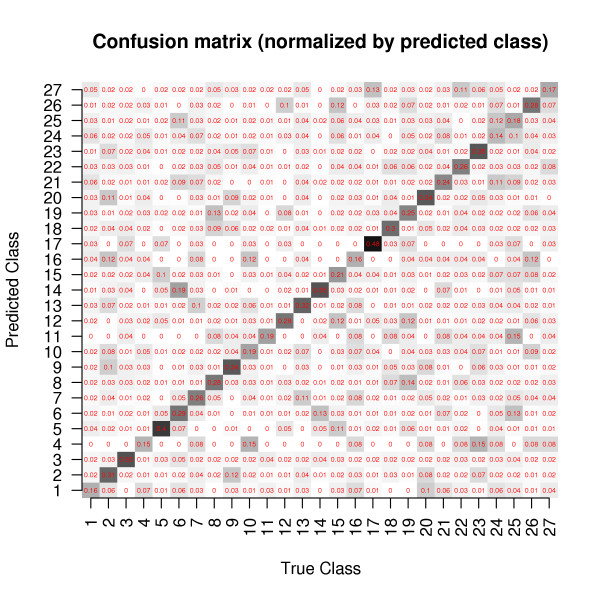
Prediction-conditioned confusion matrix (RF classifier).